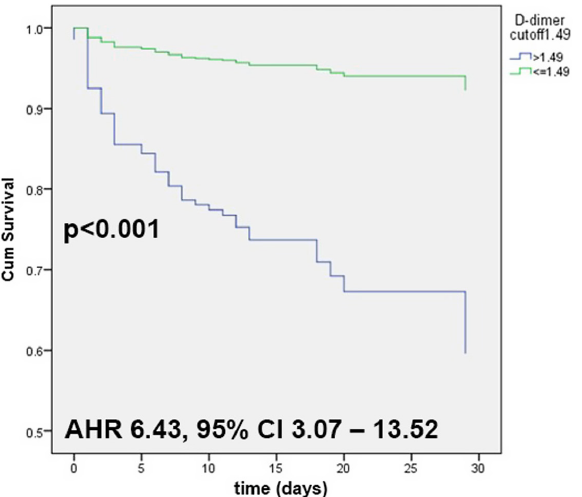
Figure 2. The adjusted Kaplan–Meier survival curves among COVID-19 patients. COVID-19, coronavirus disease 2019. Table 2. Adjusted Hazard Ratio (HR) of In-Hospital Mortality Among Patients with COVID-19 for D-Dimer, Sex, and Coexisting Disorders Variable Adjusted HR 95% CI